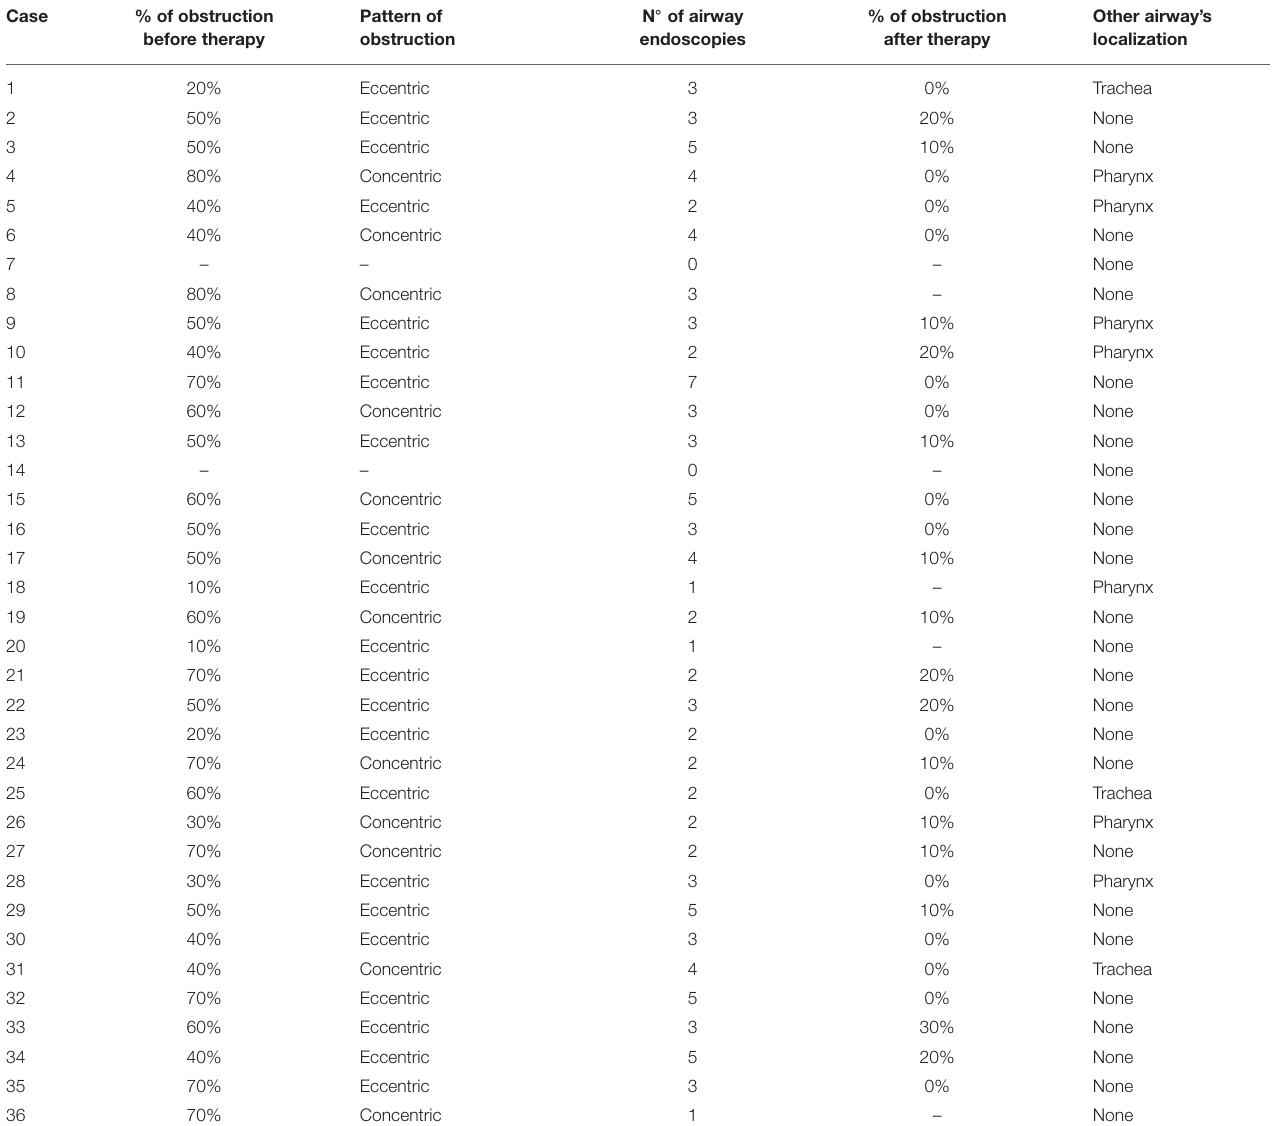
TABLE 2 | Endoscopic characteristics of the 36 patients.